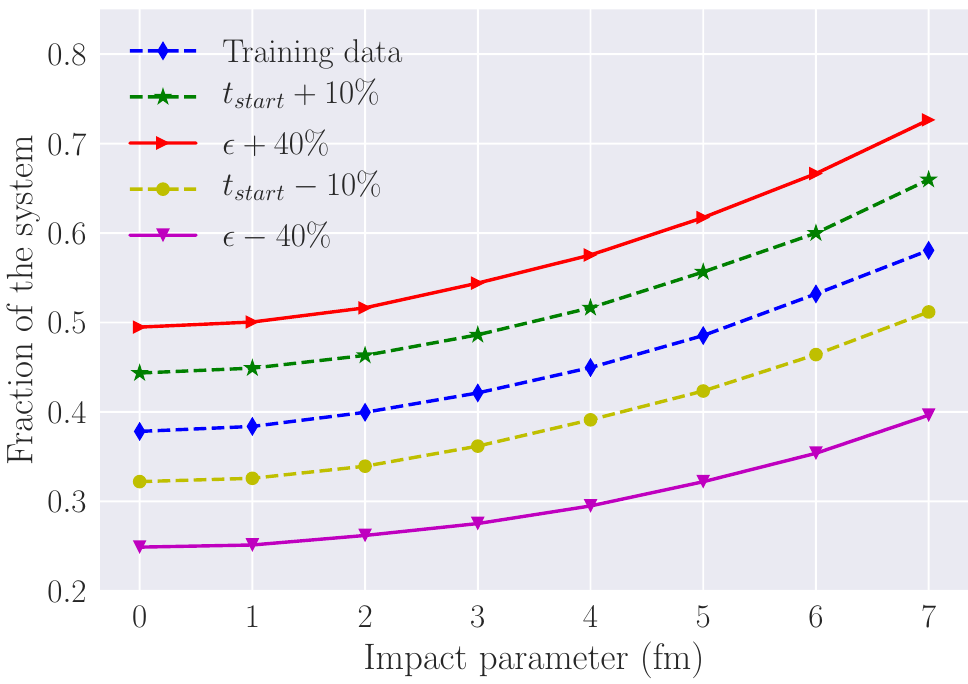
Figure 5 . (Color online) Fraction of the medium which is below the freezout energy density at the beginning of hydrodynamics as a function of impact parameter. This is simply the fraction of the medium which does not undergo the hydrodynamic evolution. The blue curve represents the initial conditions used while training the model. Curves above the blue curve corresponds to the initial conditions which reduces the duration of hydrodynamic evolution and vice